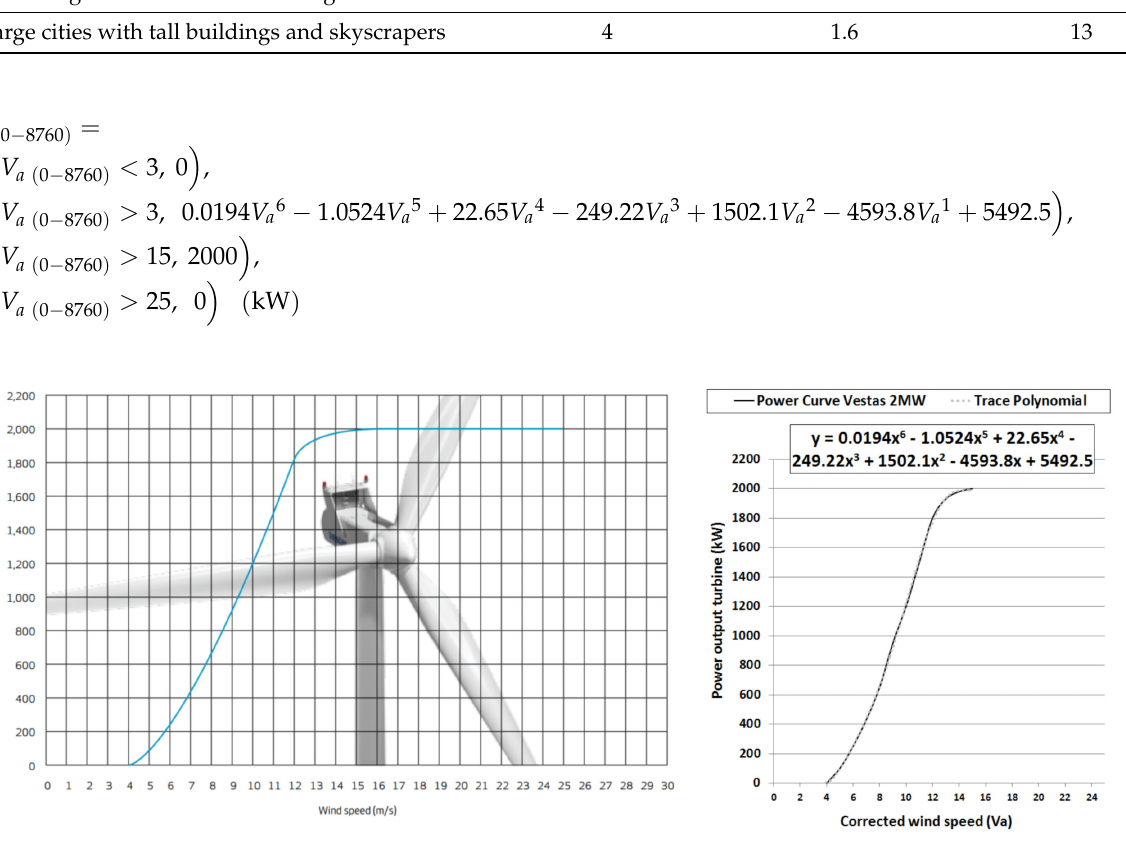
Figure A3. Power curve for on land Vestas V-80 2MW turbine